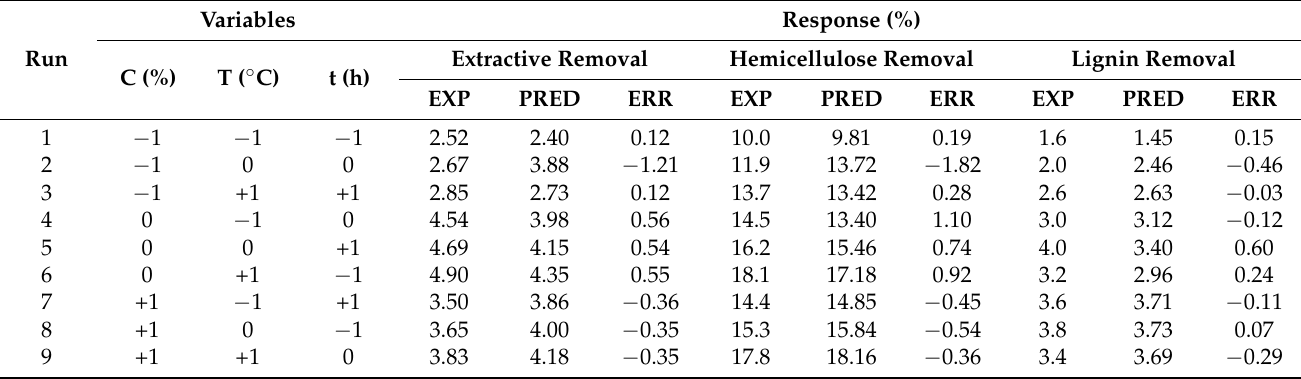
Table 5. Experimental and predicted removals of non-cellulosic components of